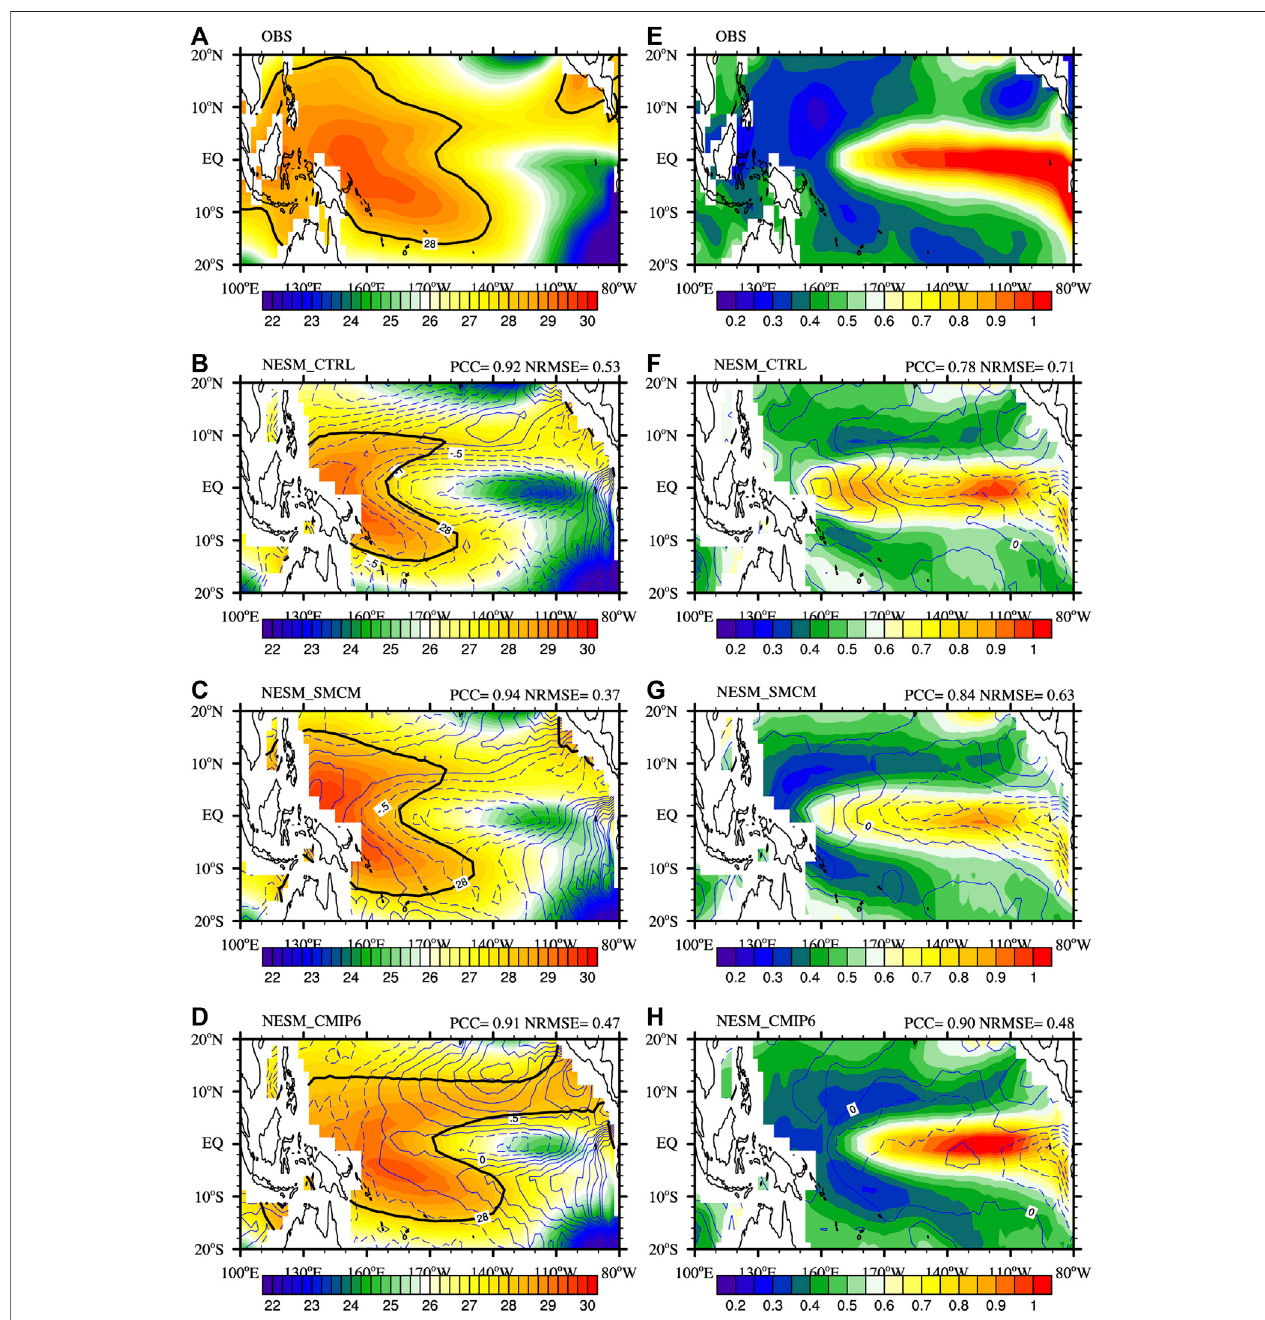
FIGURE 3 | Annual mean (left panel; ° C) and standard deviation (right panel; ° C) of the sea surface temperature: (A,E) observations, (B,F) NESM_CTRL, (C,G) NESM_SMCM,and (D,H) NESM_CMIP6.Thelinesrepresent thebiasesrelativetotheobservation(CI (cid:2) 0.25forannualmean;CI (cid:2) 0.1forstandarddeviation). Thethick black lines in (A – D) denote the 28 ° C